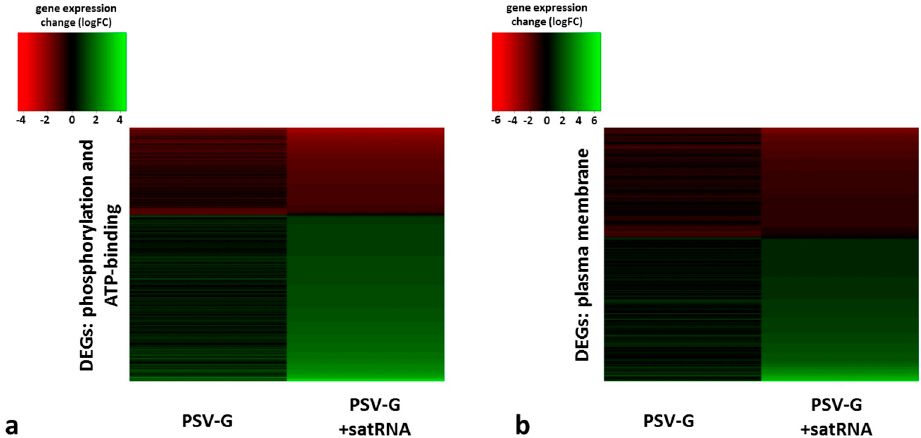
Figure 6. Heatmaps showing distribution of GO terms assigned to the DEGs of PSV-G and PSV-G + satRNA infected plants. ( a ) Combined terms for phosphorylation (Biological Process) and ATP binding (Molecular Function); ( b ) plasma membrane (Cellular Component) in PSV-G (left) and PSV-G + satRNA (right) infected plants. Table 2. Contrasting effects ( ↑— increase and ↓— decrease) of the absence or presence of satellite RNA (satRNA) in PSV-G infected Nicotiana benthamiana plants. The distribution of GO terms assigned to the differentially expressed genes under the three GO functional categories is shown.